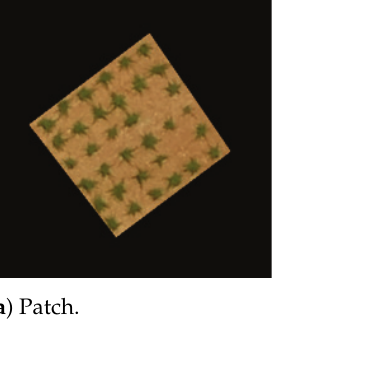
Figure 15. Learning